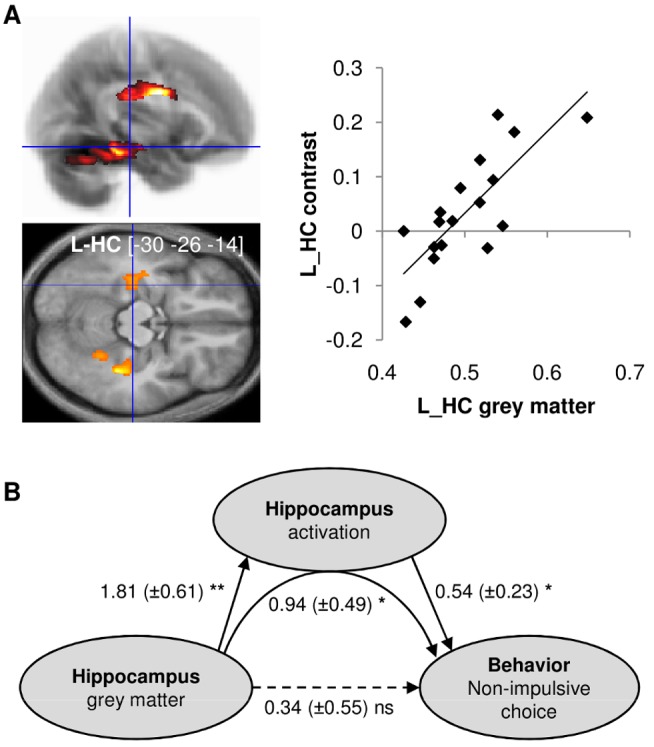
Neuro-anatomical correlates of interindividual differences in choice impulsivity.(A) Correlation between grey matter density and nonimpulsive versus impulsive choice contrast in the hippocampus ROI (cluster activated in Figure 4A). Left: Statistical parametric maps testing for higher correlation with the ecological versus control contrasts. The color code indicates the statistical significance of clusters that survived the illustrative threshold (more than 200 voxels with p<0.005). The [x y z] coordinates of local maxima refer to the Montreal Neurological Institute (MNI) space. Right: scatter plot for illustration of the anatomo-functional correlation in the ecological condition. Diamonds represent individuals; solid line indicates robust regression fit. ROI grey matter estimates were obtained from the intersection between the clusters activated on the map and an anatomical delineation of the hippocampus. L-HC, left hippocampus. (B) Mediation analysis of the links between anatomy, activity, and behavior. Grey matter density and functional activation were extracted from the cluster of Figure 4A, intersected with an anatomical delineation of the hippocampus. Solid and dashed arrows indicate significant and nonsignificant paths, respectively. Regression coefficients and standard errors (in brackets) are noted for each path. Statistical significance: * p<0.05; ** p<0.01; ns, non-significant.